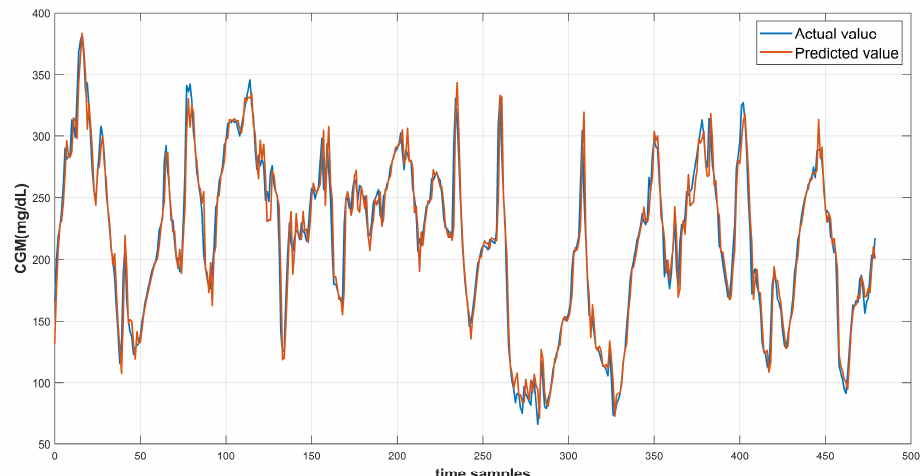
Figure 14. Prediction curve for patient ID 570 at PH of 30 min.